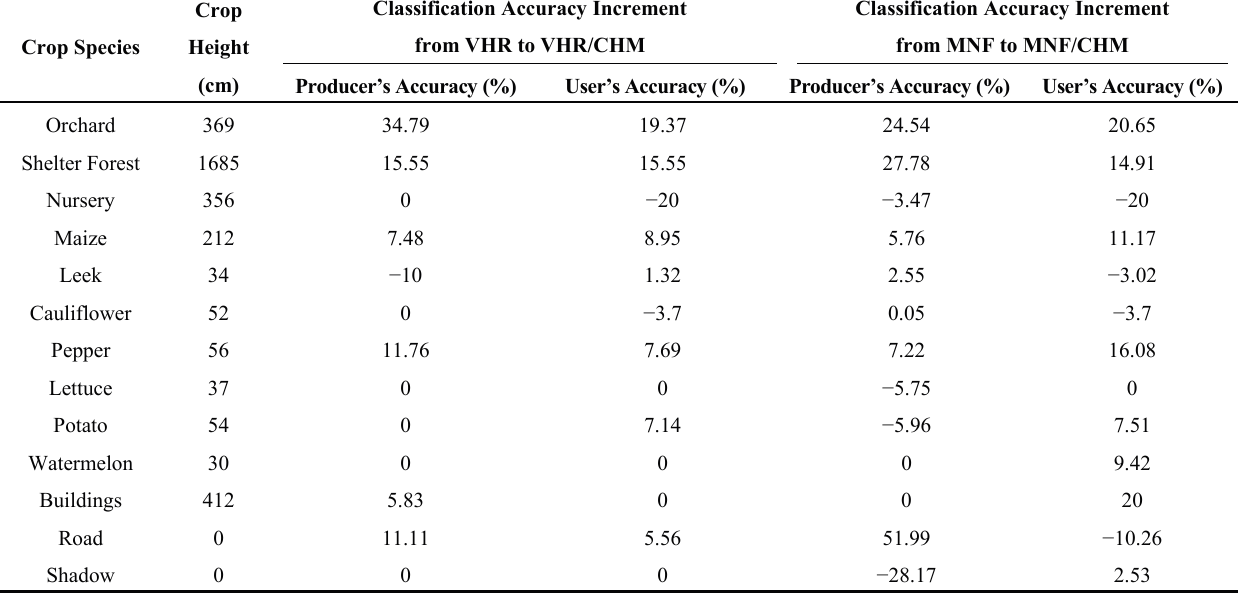
Table 6. Plant heights and classification accuracy increments from VHR to VHR/CHM, and from MNF to MNF/CHM-based